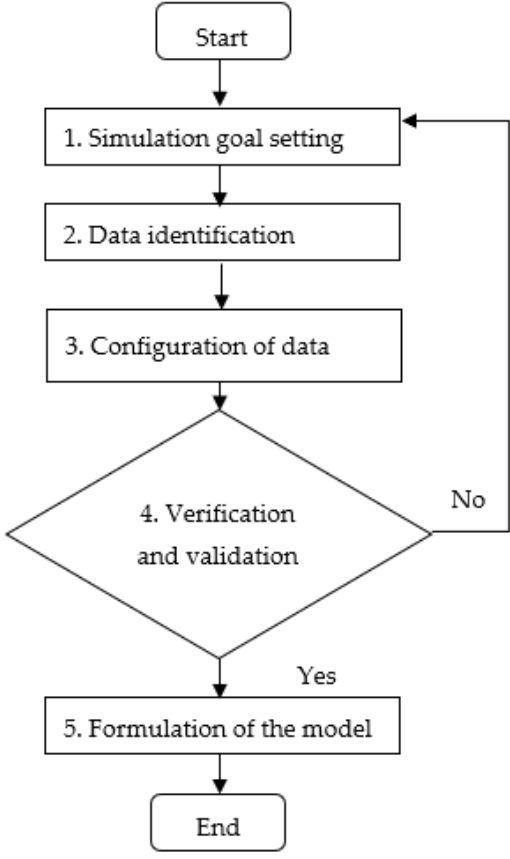
Figure 4. Simulation methodology process.